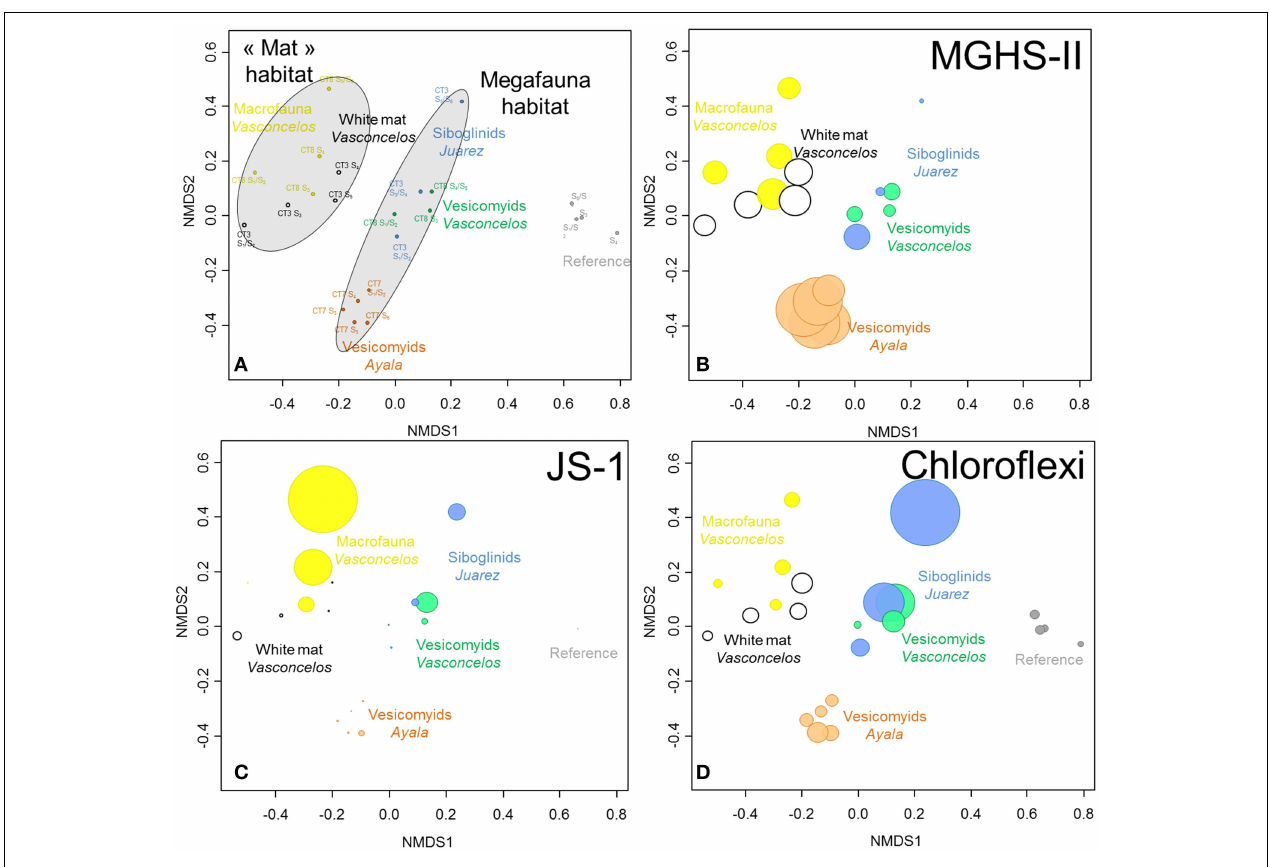
FIGURE 4 | (A) NMDS ordination plots derived from the Bray-Curtis similarity measure between samples based on taxonomic affiliation of pyrosequencing reads for Bacteria . Stress = 0.09. (B–D) Size of colored circles (gray: Reference, orange: Ayala—vesicomyids , blue: Juarez—siboglinids ,